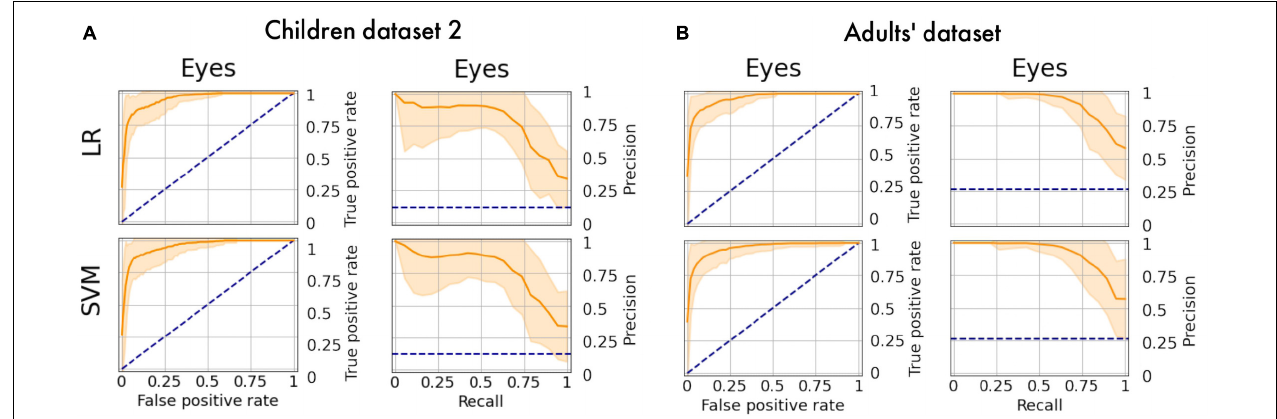
FIGURE 8 | PR curves and ROC curves for Eyes class for additional datasets. The performance rate for additional datasets illustrated using ROC-curve and PR-curve. The solid line indicates the mean curve and the colored area indicates the 95% confidence interval for the curves. (A) Is a pair of plots for Children dataset 2 and we observe that both plots illustrate high quality of predictions for Eye components. (B) Is a pair of plots that show a high performance rate for Eye components for Adults’ dataset.